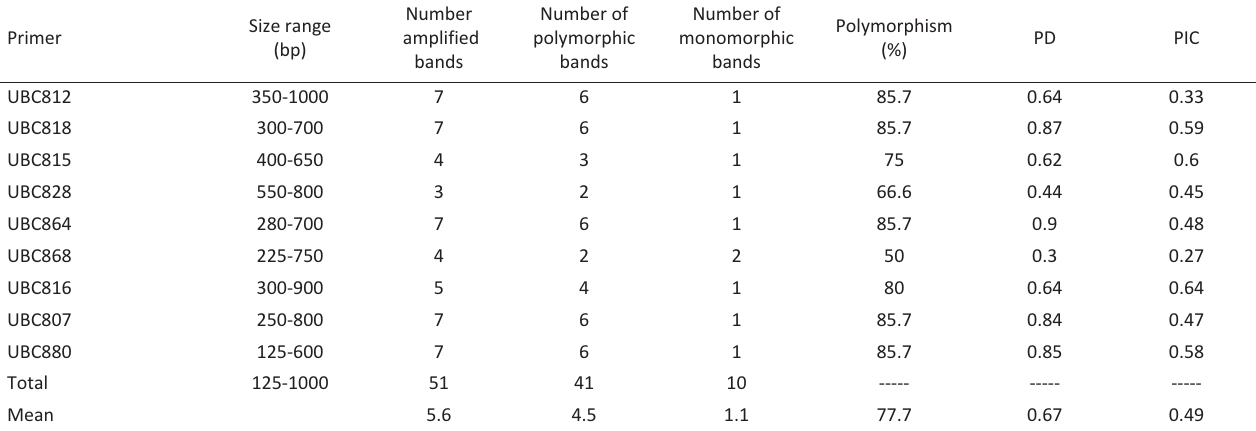
Table 2 ­ The resulting discriminating power, number of polymorphic and monomorphic, the size of bands of ISSR primers, percentage of polymorphism and the polymorphic information content Number Number of Size range Primer amplified polymorphic (bp) bands